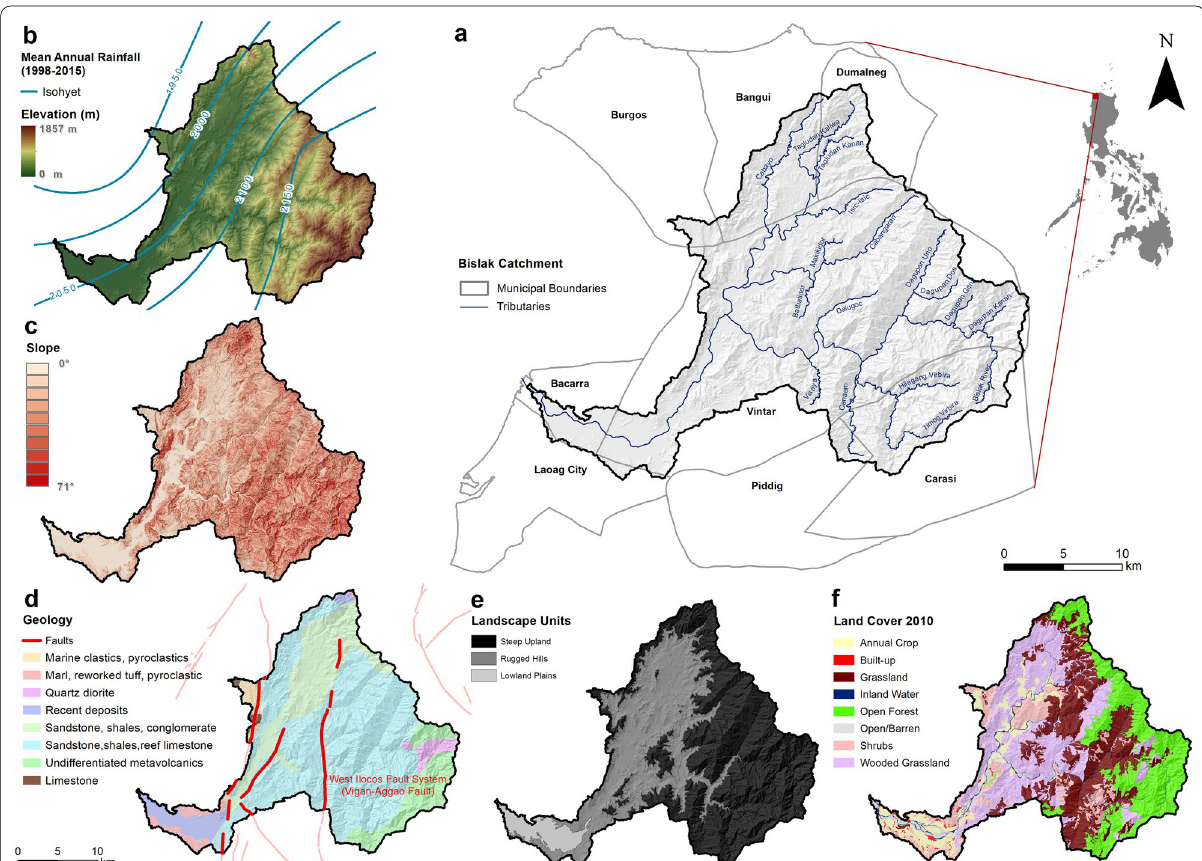
Fig. 2 Catchment and regional setting maps, including: a location map of the Bislak Catchment; b elevation and isohyet of rainfall distribution; c catchment slope; d geology and fault map (PHIVOLCS 2015; MGB 2010; NAMRIA 2010); e distribution of landscape units; and, f land cover (NAMRIA